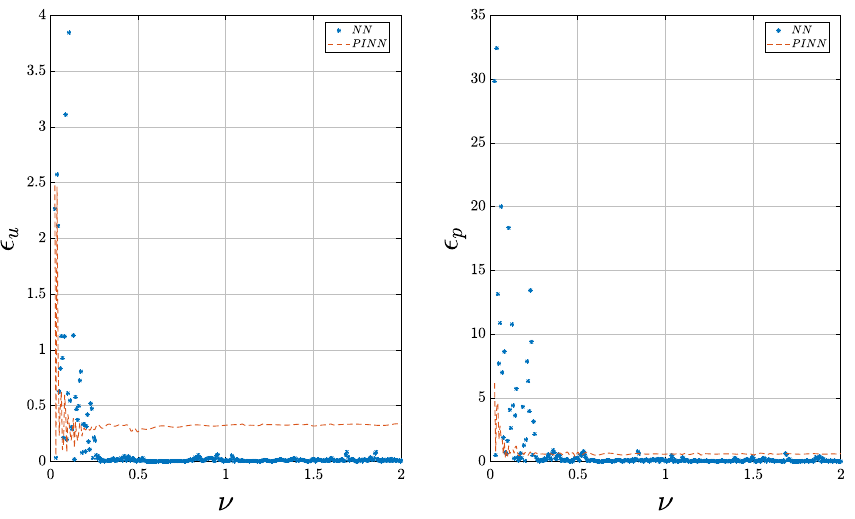
Fig. 4 The L 2 relative error for the POD-NN and POD-Galerkin PINN ROMs for both the velocity field (on the left) and the pressure field (on the right). The curves are already in percentages, the values of the errors are depicted versus the test values of the physical viscosity